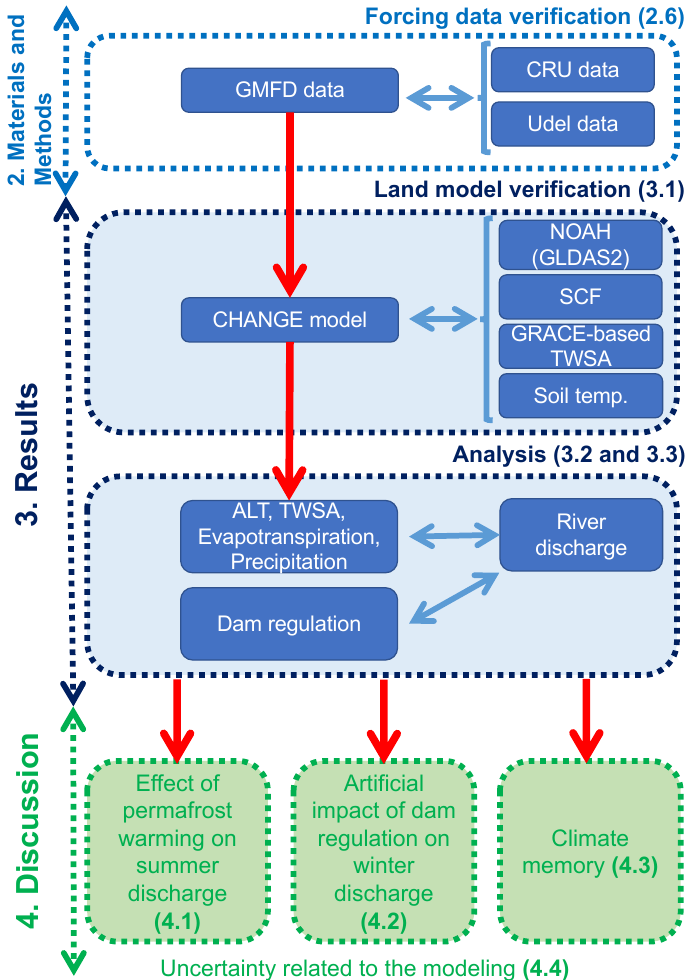
Figure 2. Analysis flow in this study. The vertical axis denotes the Materials and Methods, Results, and Discussion. The number in the parentheses denotes the corresponding section. The abbrevia- tions in the figure are as follows: GMFD: Global Meteorological Forcing Dataset for land surface modeling [26], CRU: University of East Anglia Climatic Research Unit [29], Udel: University of Delaware Air Temperature & Precipitation [30], CHANGE: A coupled hydrological and biogeochemi- cal model [17], Global land data assimilation system v2.0 (NOAH) [35], SCF: Snow cover fraction [33], TWSA: Terrestrial water storage anomaly [34], ALT: Active layer thickness